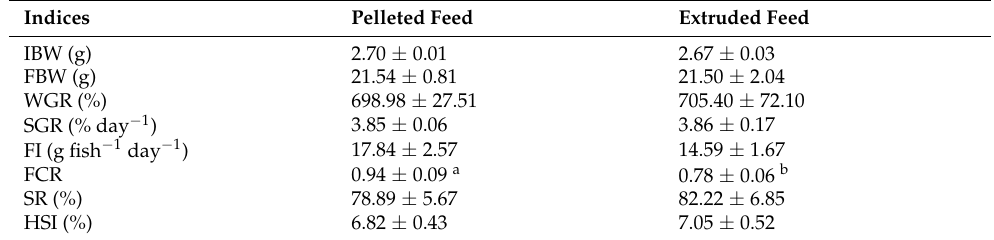
Table 4. Effects of pelleted and extruded feeds on growth performance and physical indices of P. clarkii